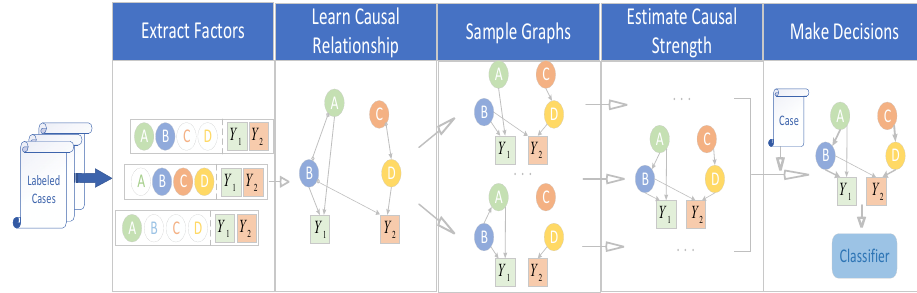
Figure 2. The overall process of GCI.